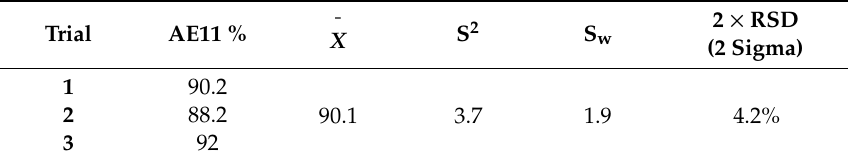
Table 12. Repeatability experiments